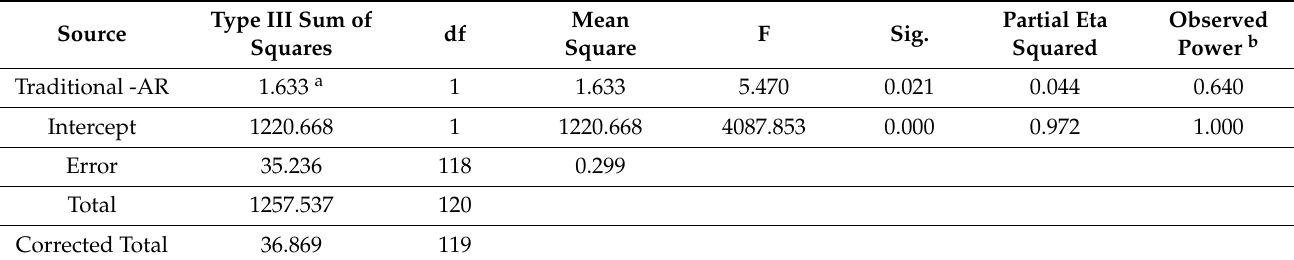
Table 2. Differences between groups in learning